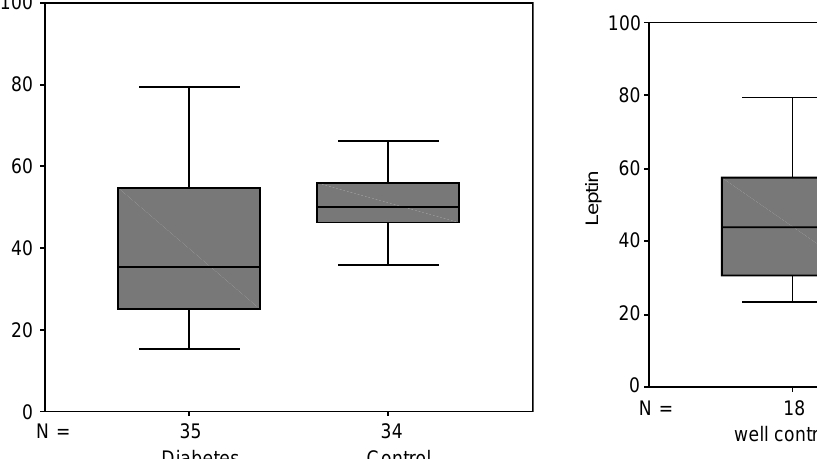
FIG. 2. Leptin levels in subjects who have well and poorly controlled diabetes mellitus (p (cid:6) /